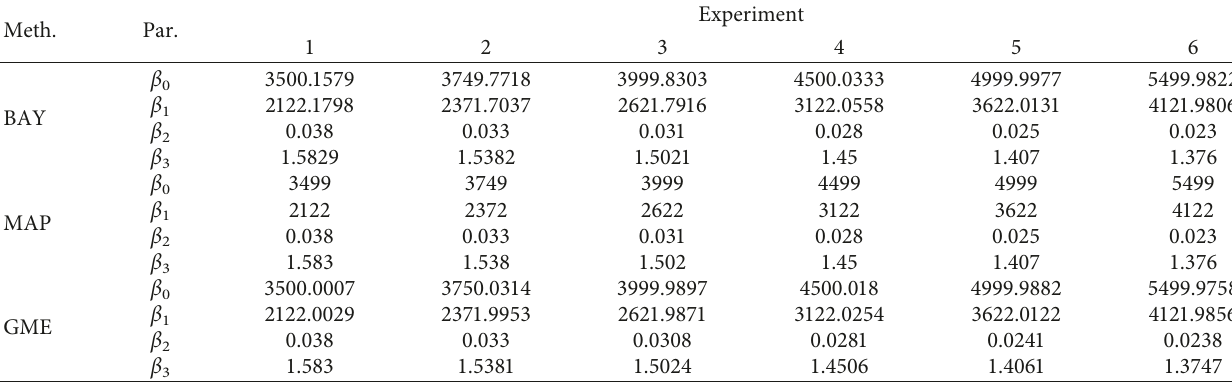
Table 2: Estimation of the parameters of the Weibull growth model using the estimation methods. Meth. Par.